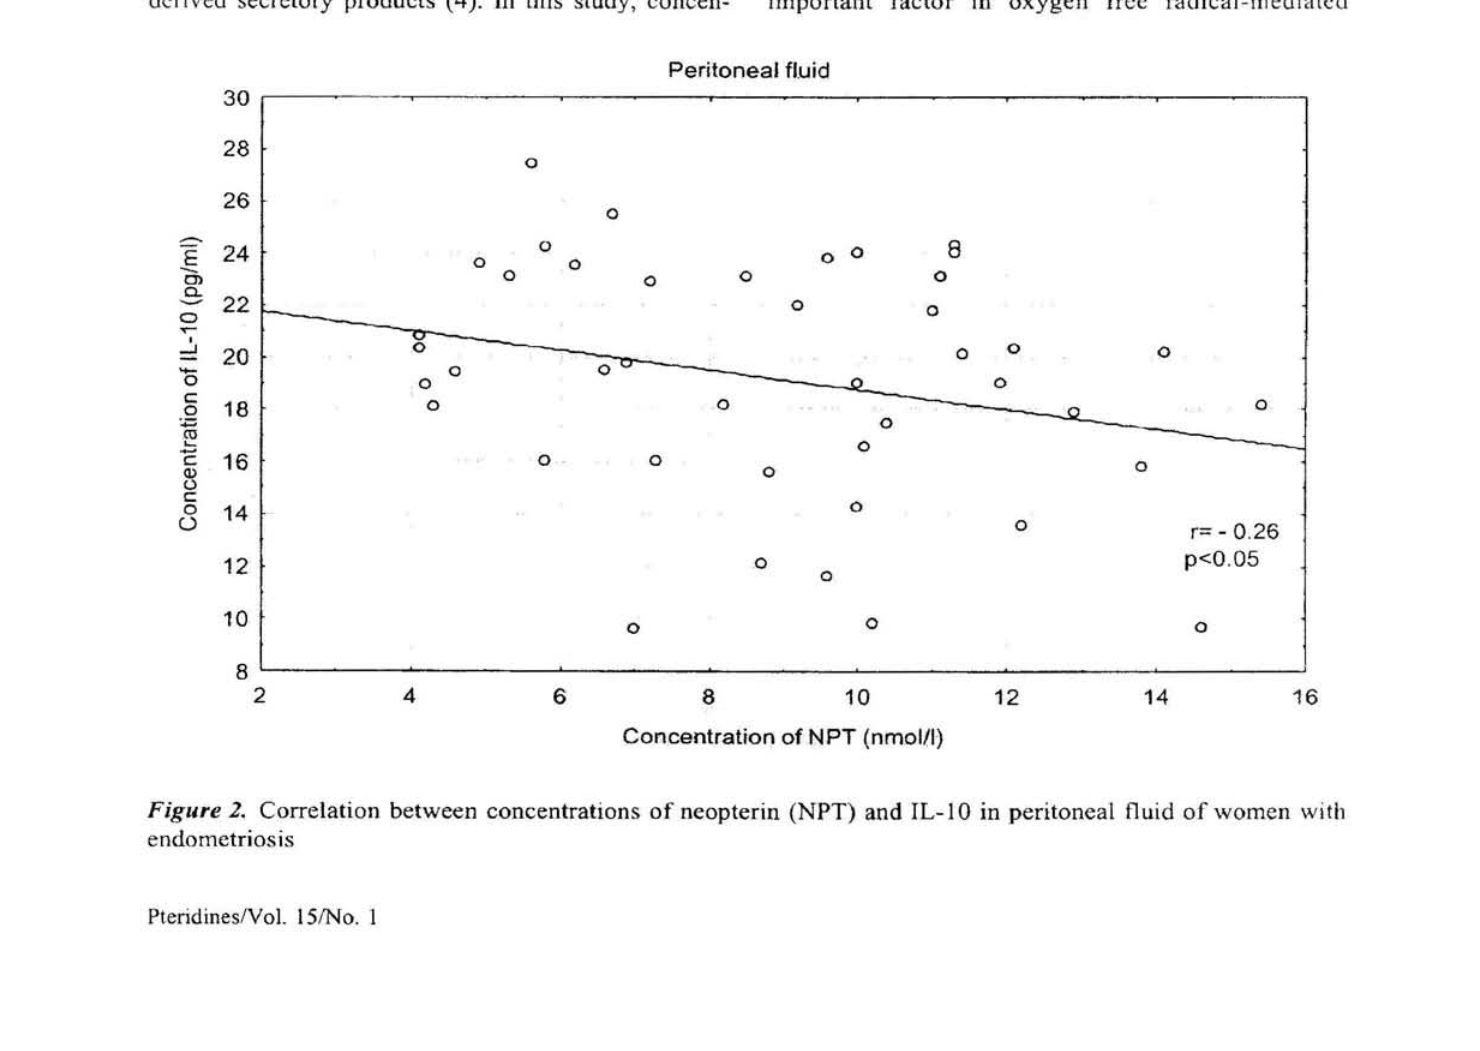
Pteridines/Vol. 15/No.